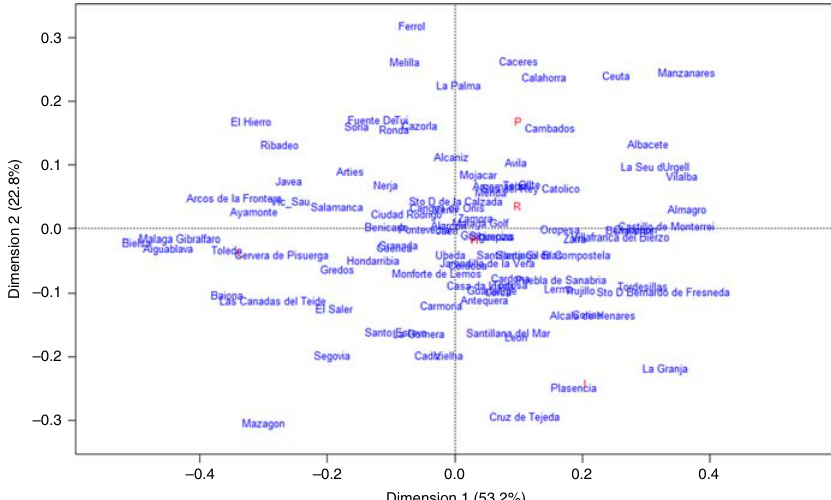
correspondence analysis by Parador of the frequency of comments mentioning value chain